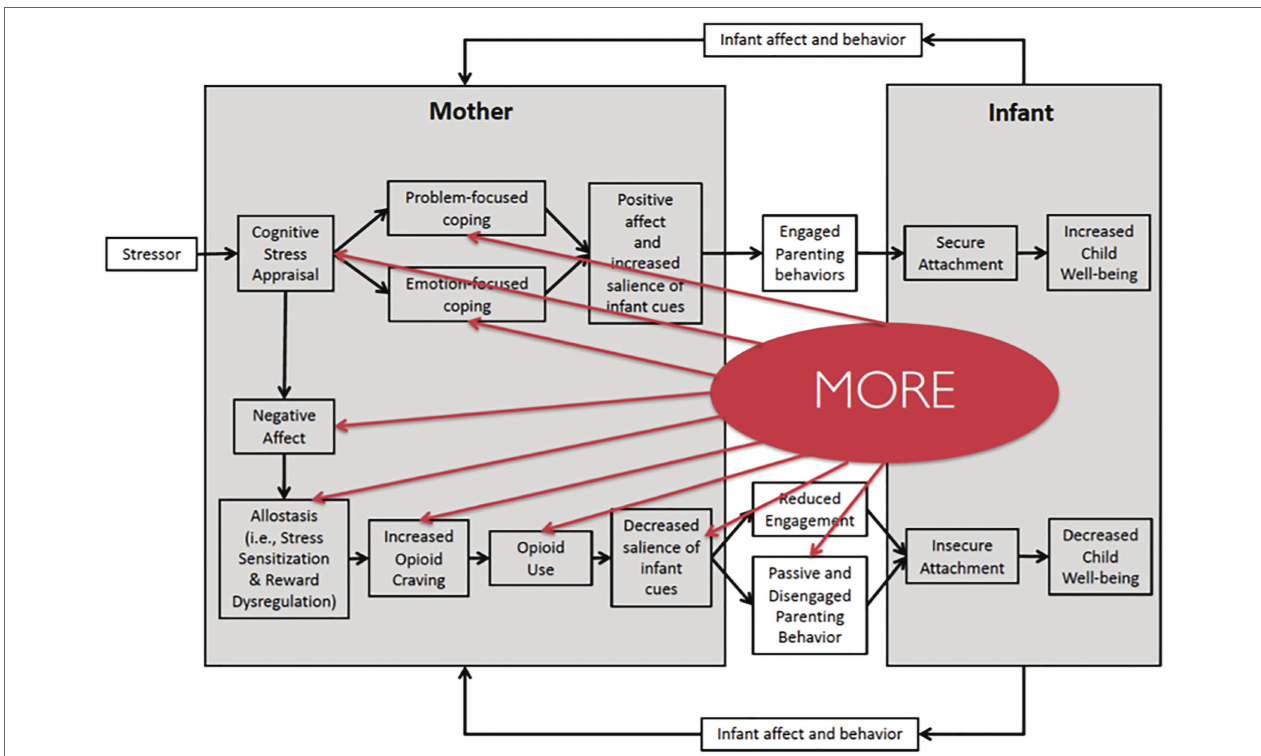
FIGURE 2 | Mindfulness-Oriented Recovery Enhancement (MORE) targets mechanisms of maternal substance use and child well-being. MORE may interrupt several key processes in the proposed model of perinatal opioid use and child well-being. MORE promotes the process of mindful reappraisal , whereby a mother can change her perspective on a stressor to decreased her negative affect. MORE also fosters problem-focused and emotion-focused coping, during which a mother uses mindfulness practices to cope with emotional distress. MORE also targets the process of allostasis, reduces sensitization to stress, and increases sensitization to reward. MORE also provides strategies to cope with substance craving, decreasing the likelihood of substance use. Finally, mindful savoring may help women increase the salience of infant cues and promote engaged parenting